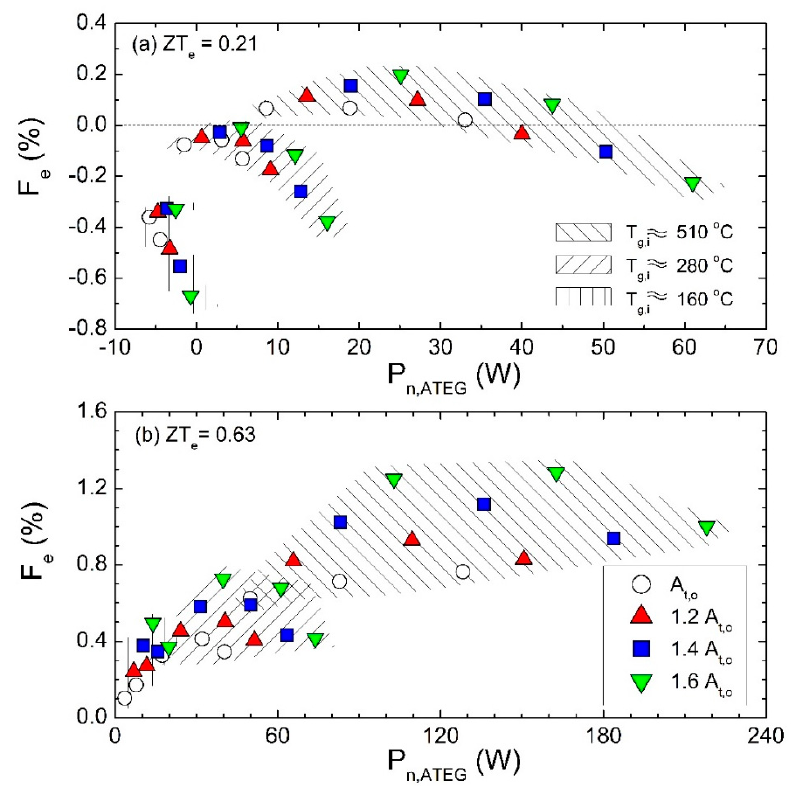
Figure 16. Fuel economy as a function of net ATEG power production for all cases when using TEMs with an effective figure of merit ( a ) ZT e = 0.21 and ( b ) ZT e = 0.63. Numerical results.